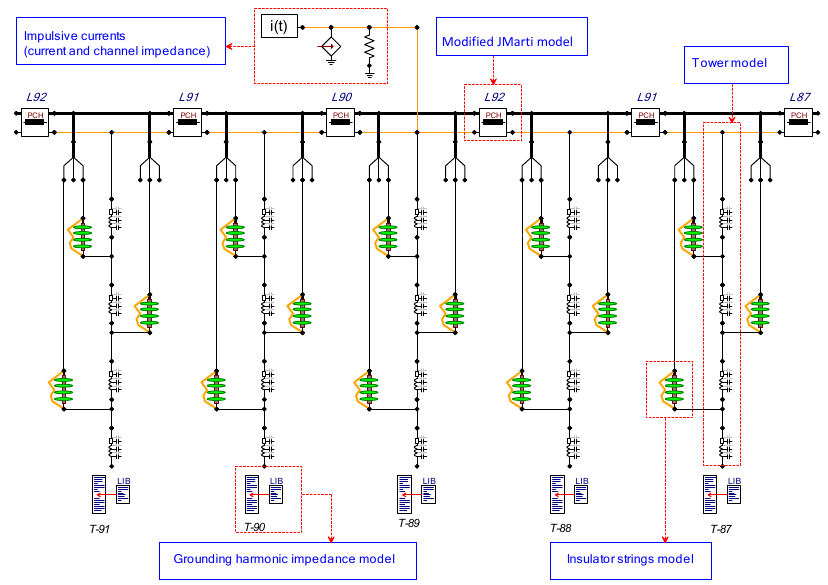
Figure 7. System transmission implementation in